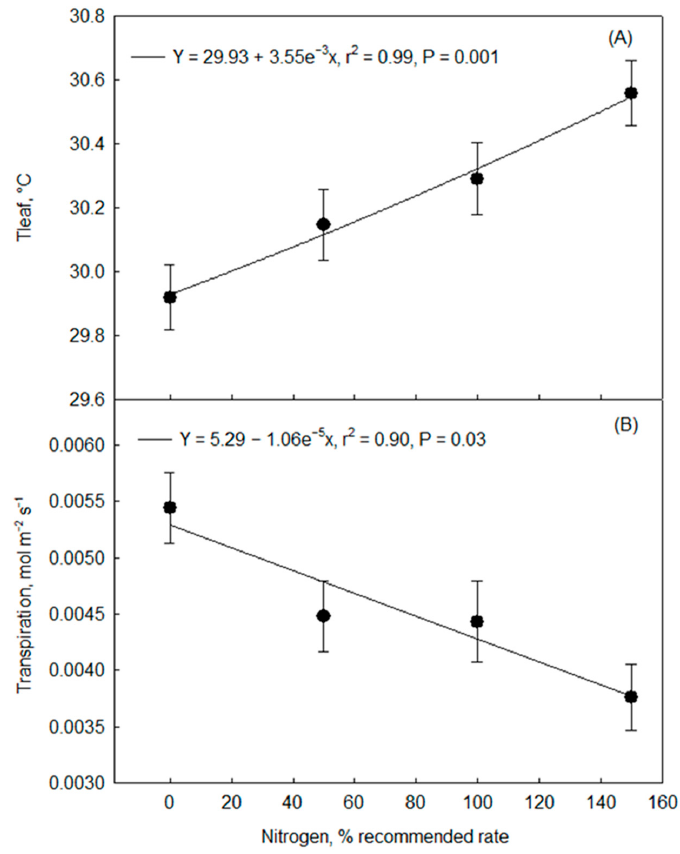
Figure 8. Nitrogen treatment effect on leaf temperature ( A ) and transpiration ( B ) of cotton at 60 days after planting. Data are means ± Standard error ( n = 64 plants in total for fourreplications and two